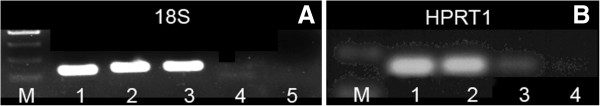
Composite image of nanodrop spectrophotometry of amplified and labelled probes of spotted oligonucleotide microarrays. Images A and B are nanodrop spectrophotometry of second round of amplification and labelled probe of a microarray sample (C0404 LEC) respectively. These graphs were used to determine the quality of the amplification and labelling of the sample for further processing. Image 4A of the amplified RNA demonstrates RNA concentration and 260/280 ratio which shows absence of protein contamination. The overall graph curve indicates good quality of amplified RNA. Image 4B of the labelled probe gives the concentration of the sample with frequency of incorporation of the dye in the sample.